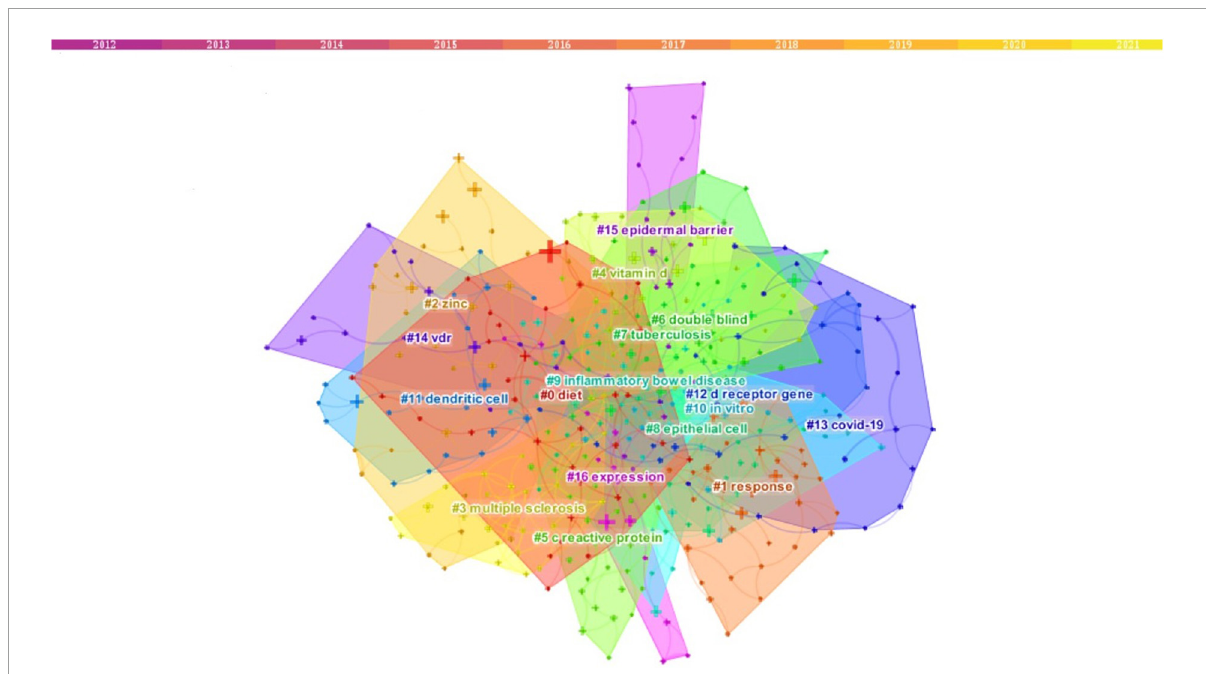
FIGURE5 Keyword cluster analysis (2012–2021). There are 17 clusters in all, distinguished by different colors. Cluster #0 is the largest, following by cluster #1, and so on. The topic term used more frequently in relevant articles was assigned by CiteSpace as the cluster label. The top five clusters are “diet,” “response,” “zinc,” “multiple sclerosis,” and “vitamin